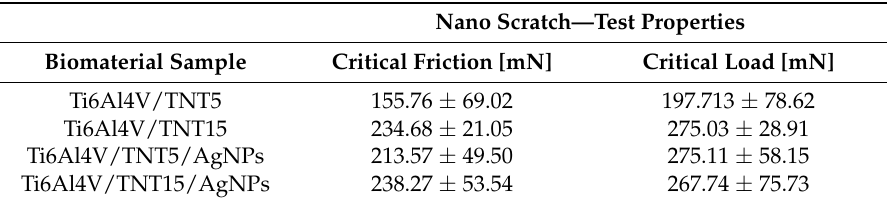
Table 6. Results of nano scratch-tests of Ti6Al4V/TNT and Ti6Al4V/TNT/Ag composites.